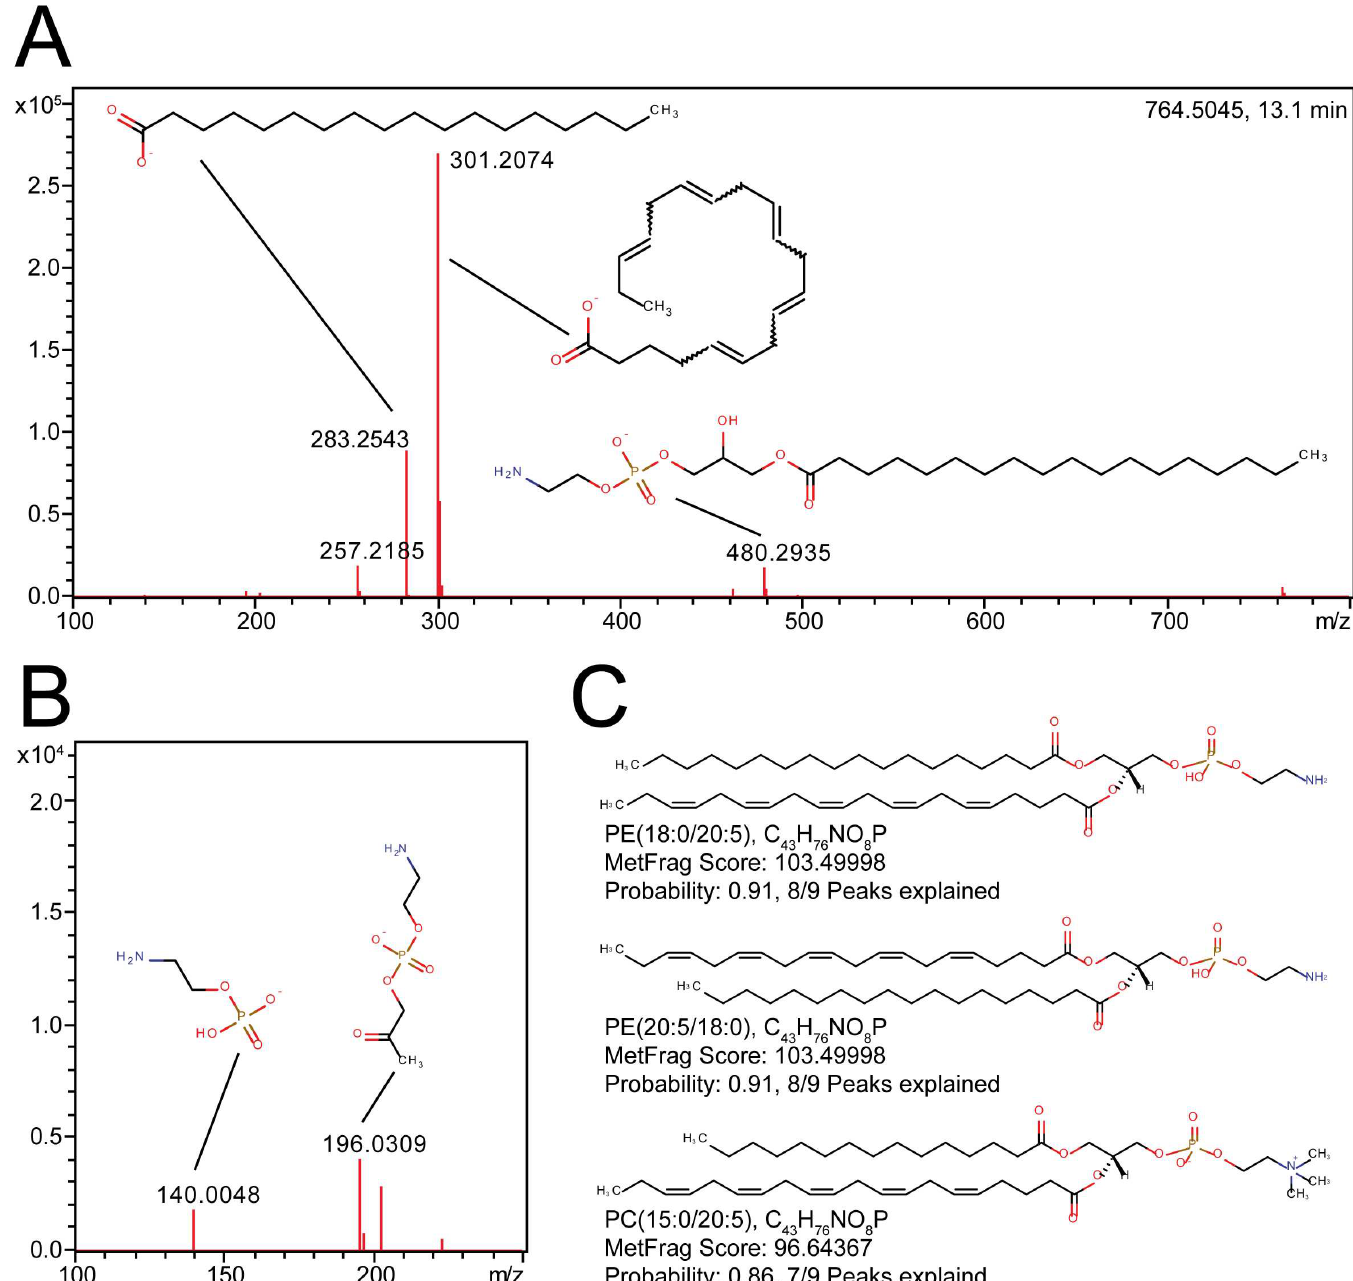
Fig 5. Example of a LipidFrag identification in C . elegans data. (A) MS/MS spectrum of m/z 764.5045 at 13.1 minutes detected in C . elegans with fragment structures annotated. (B) Close up of lower mass region(m/z 100–250).(C) Structures of the best three candidates obtainedfrom MetFrag with result filtering using foregroundclass probabilities. Name, formula, MetFrag score and probabilityare indicatedbeloweach structure.